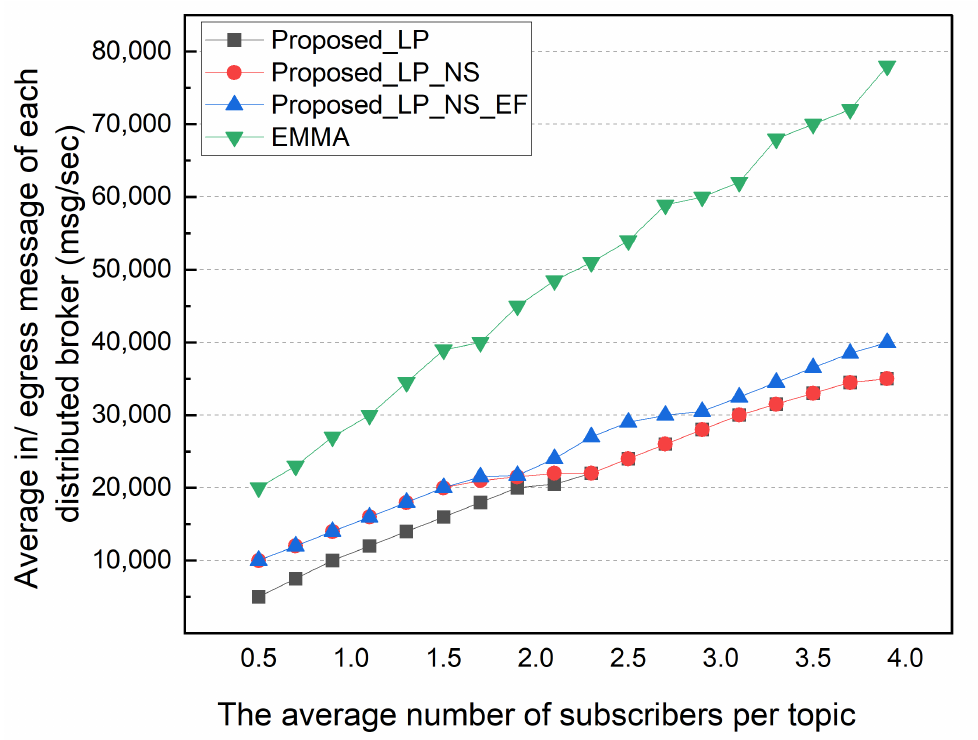
Figure 12. Average of ingress/egress messages according to subscribers per